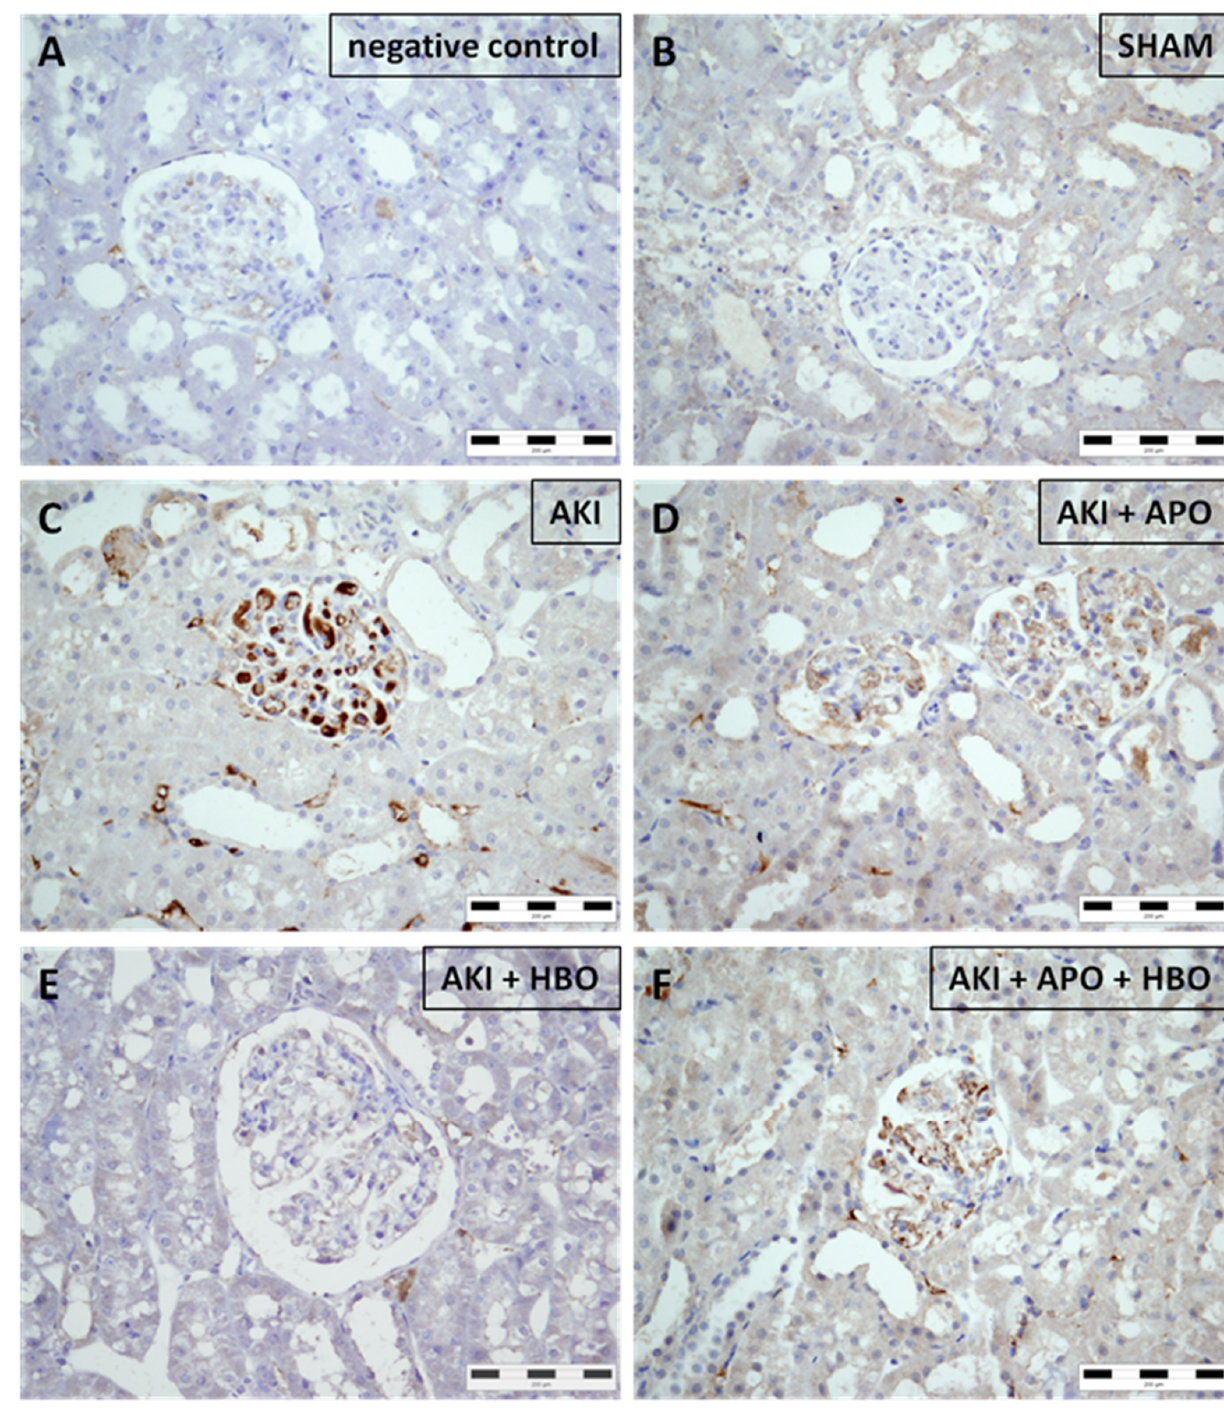
Figure 4. Immunohistochemical 4-hydroxynonenal (4-HNE) expression in representative kidney samples collected in different experimental groups (× 400 magnification): negative control ( A ), SHAM ( B ), AKI ( C ), AKI + APO ( D ), AKI + HBO ( E ), AKI + APO + HBO ( F ). SHAM—sham-operated rats; AKI—rats with induced postischemic acute kidney injury; AKI + APO—animals with acute kidney injury and apocynin treatment; AKI + HBO—group exposed to HBO preconditioning before acute kidney injury induction; AKI + APO + HBO—animals exposed to HBO preconditioning before and treated with apocynin after acute kidney injury induction.